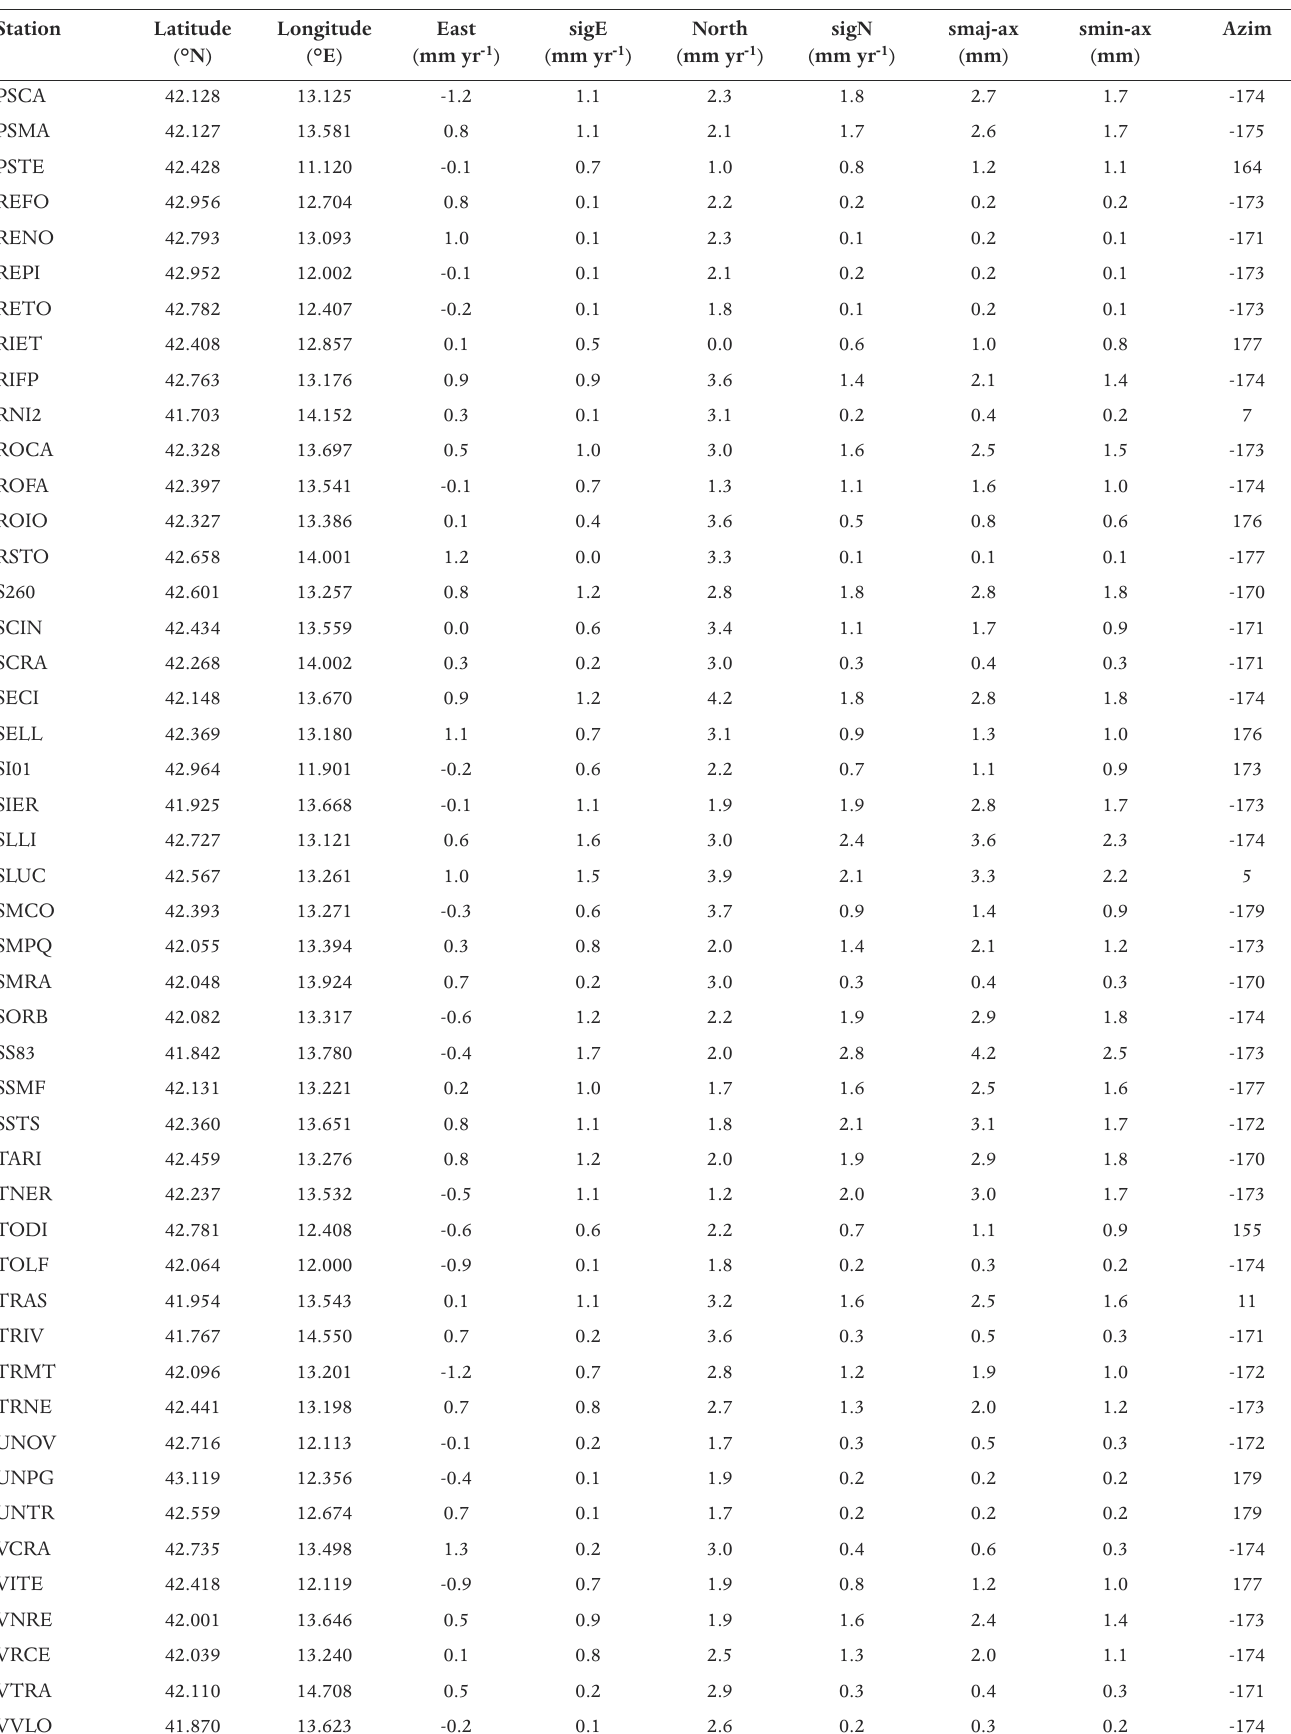
Table1 (continues from previous page). Velocity field dataset of the CAGeoNet and of the surrounding continuous GPS stations used in the analysis. East, North, velocities; sigE, sigma E; sigN, sigma N; smaj-ax, smin-ax, error ellipses; Azim,